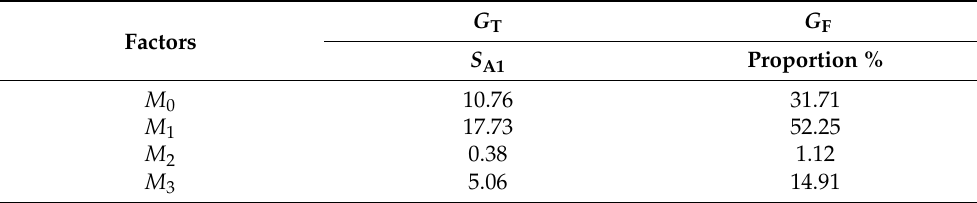
Table 7. The influence proportion of different variables on G T and G F